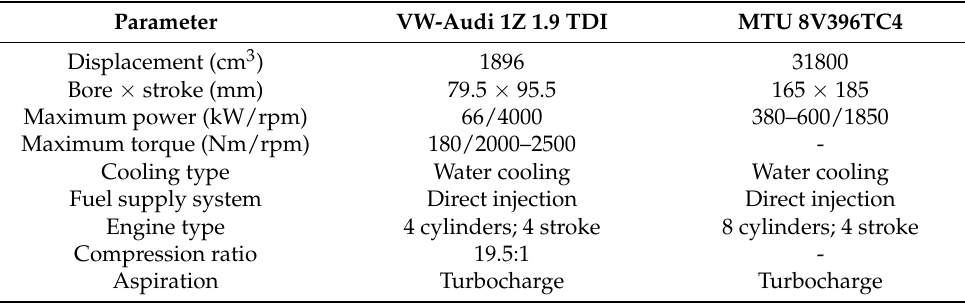
Table 1. Engines